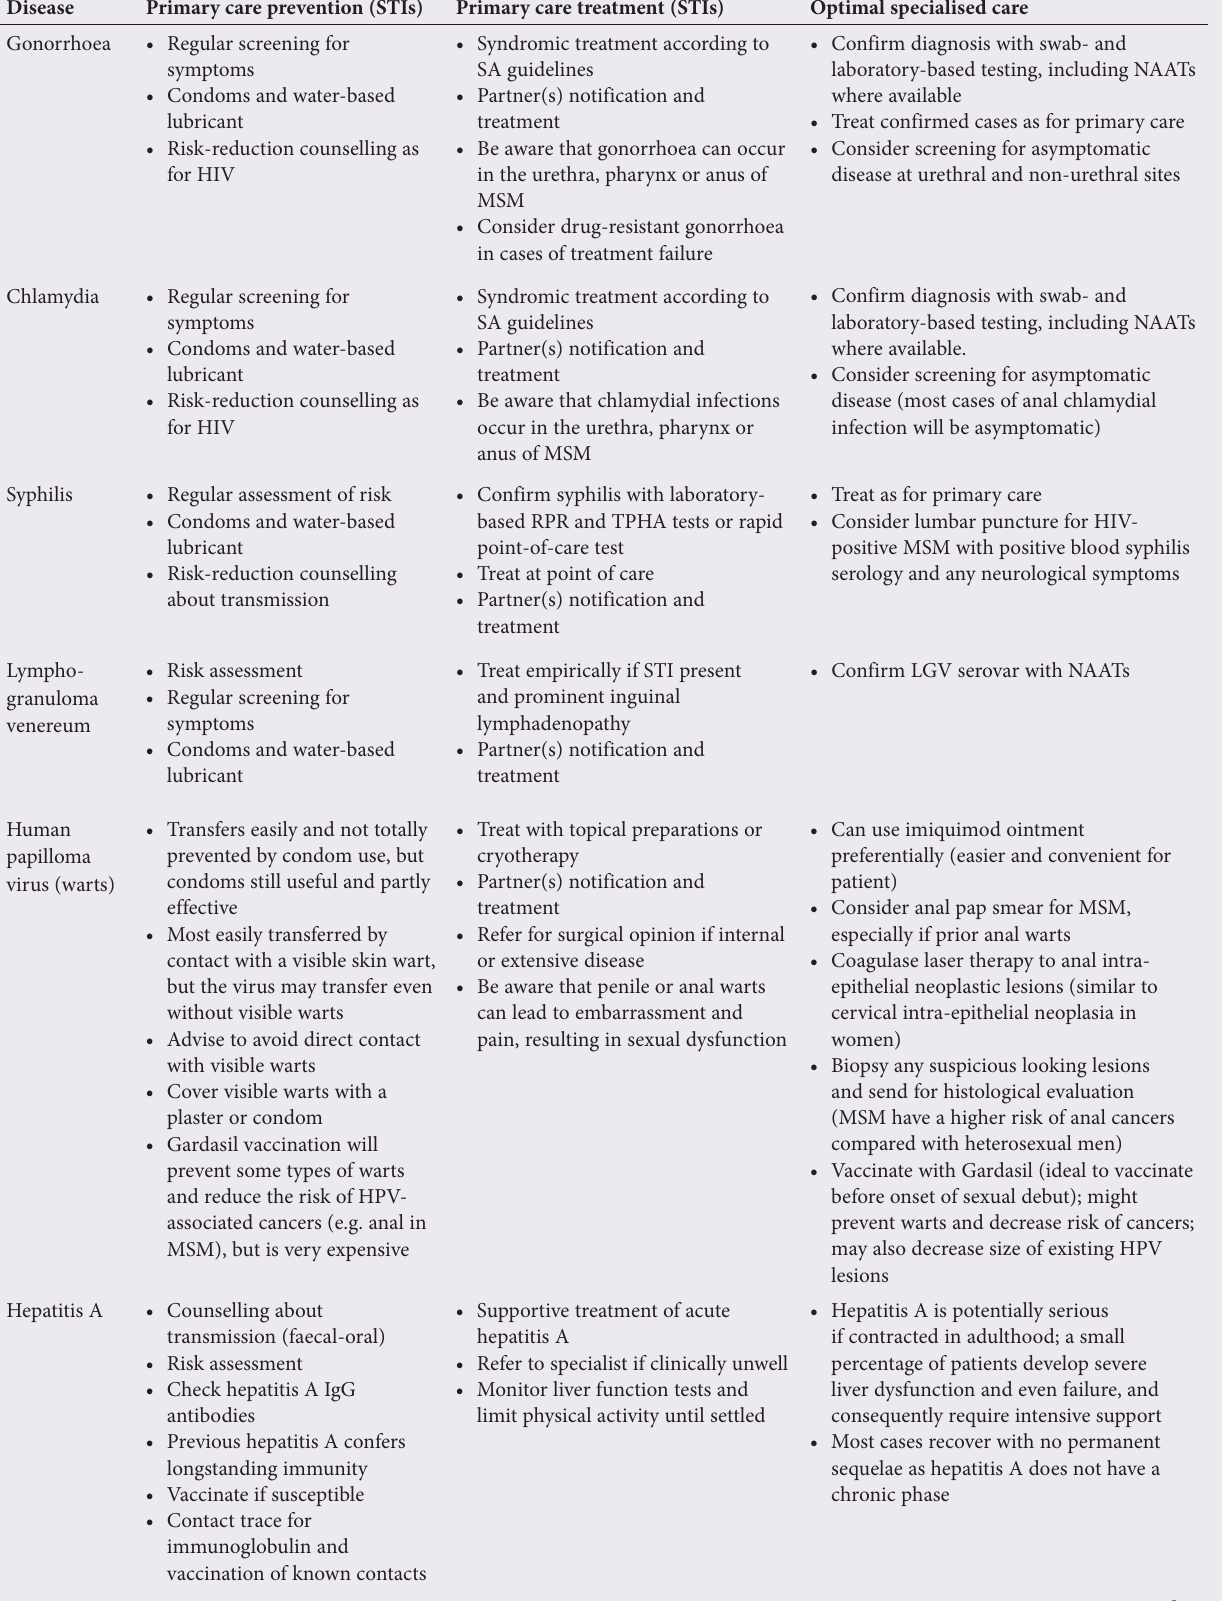
Table 2. Recommended service package for addressing the sexual health of MSM: STIs